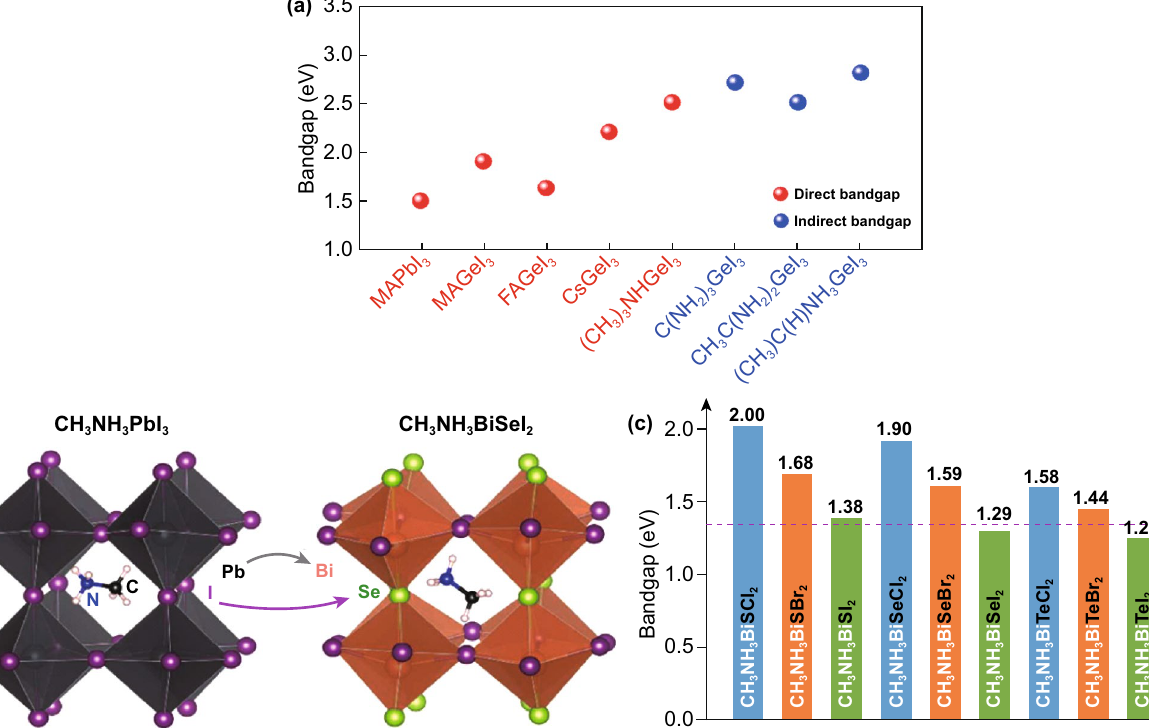
Fig. 8 a Bandgaps of various Ge-based perovskite materials compared with MAPbI 3 . b Atomic structures of MAPbI 3 and MABiSeI 2 . c Calcu- lated bandgaps of CH 3 NH 3 BiXY 2 compounds (with X = S, Se, Te and Y = Cl, Br, or I) using the Heyd–Scuseria–Ernzerhof functional with spin– orbit coupling. The dashed line marks the optimal bandgap for single-junction solar cell according to the Shockley–Queisser theory. Reproduced with permission from Ref.